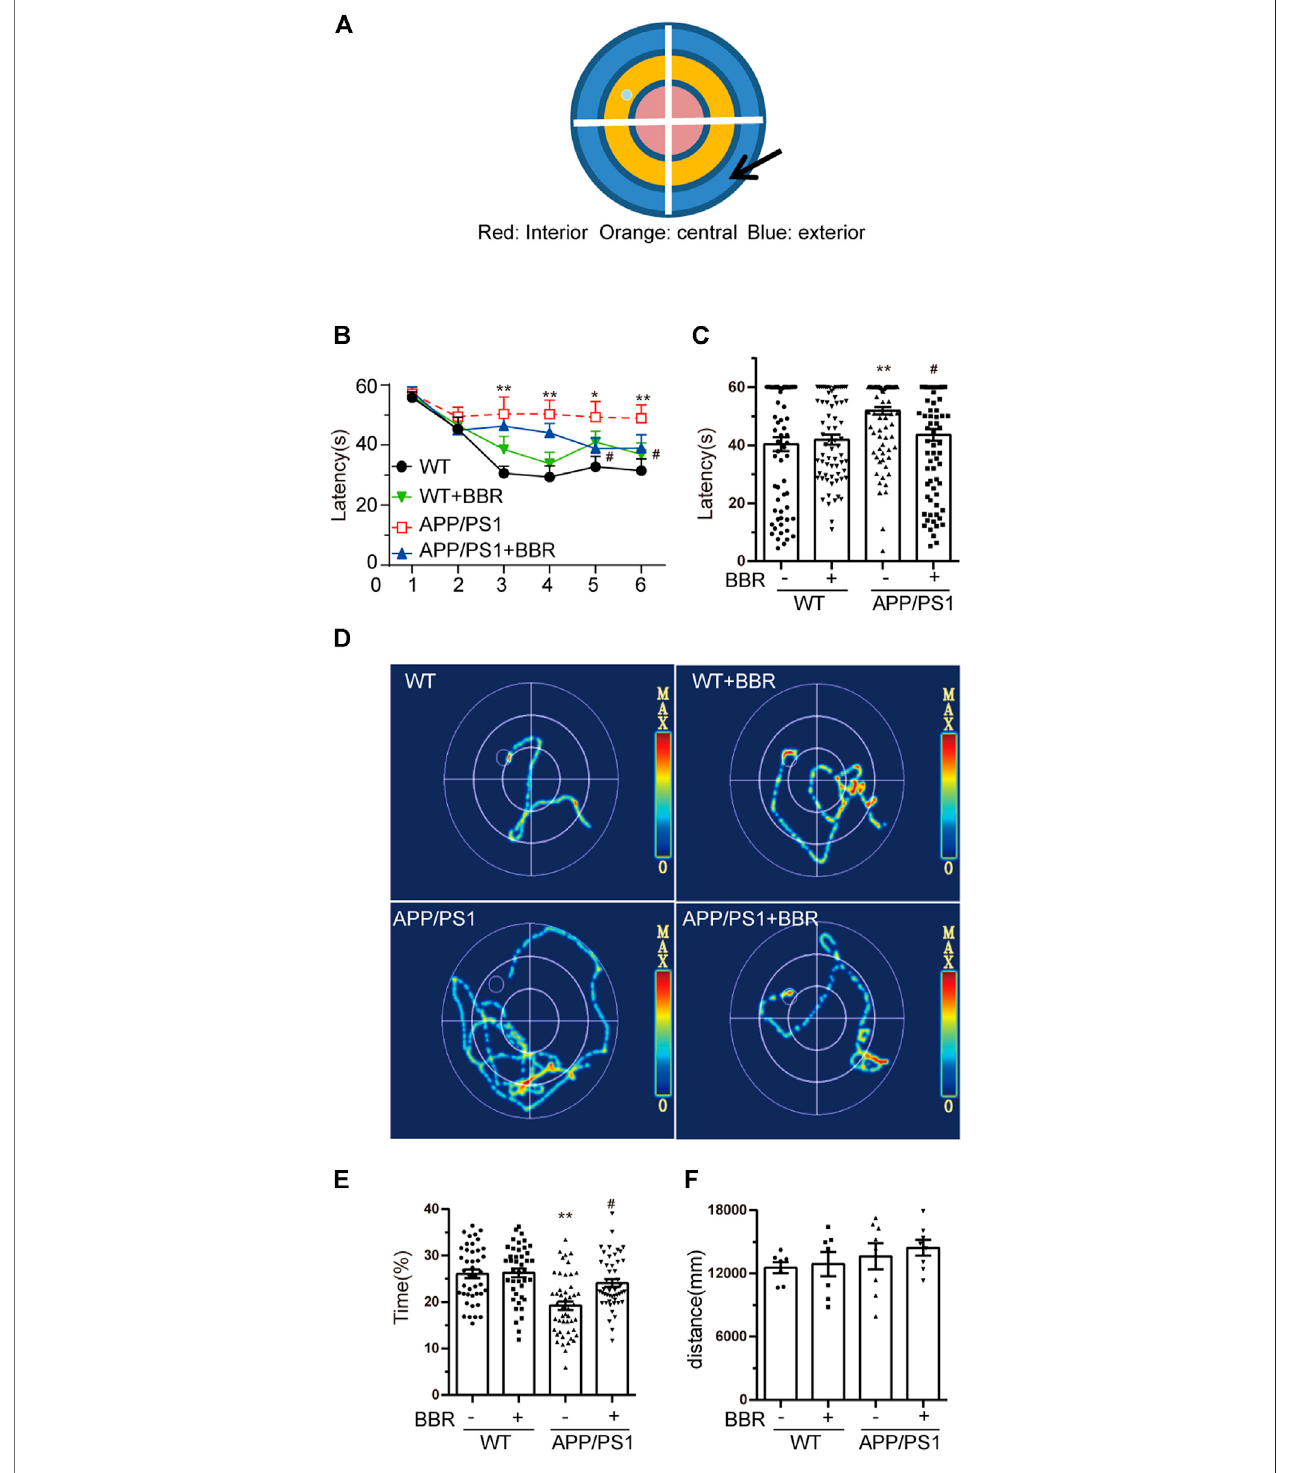
FIGURE 2 | Berberine improves the cognitive ability of APP/PS1 mice. (A) MWM schematic. (B,C) Escape latency analysis in the navigation training trials. (D) The trajectoryofmiceinMWM. (E) Thepercentoftimespentinthetargetquadrantduringthespaceexplorationexperiment. (F) Analysisofswimmingdistancesduringtrials. Data were presented as means ± SEM. * p < 0.05, ** p < 0.01 vs. WT; # p < 0.05 vs. APP/PS1 without BBR.